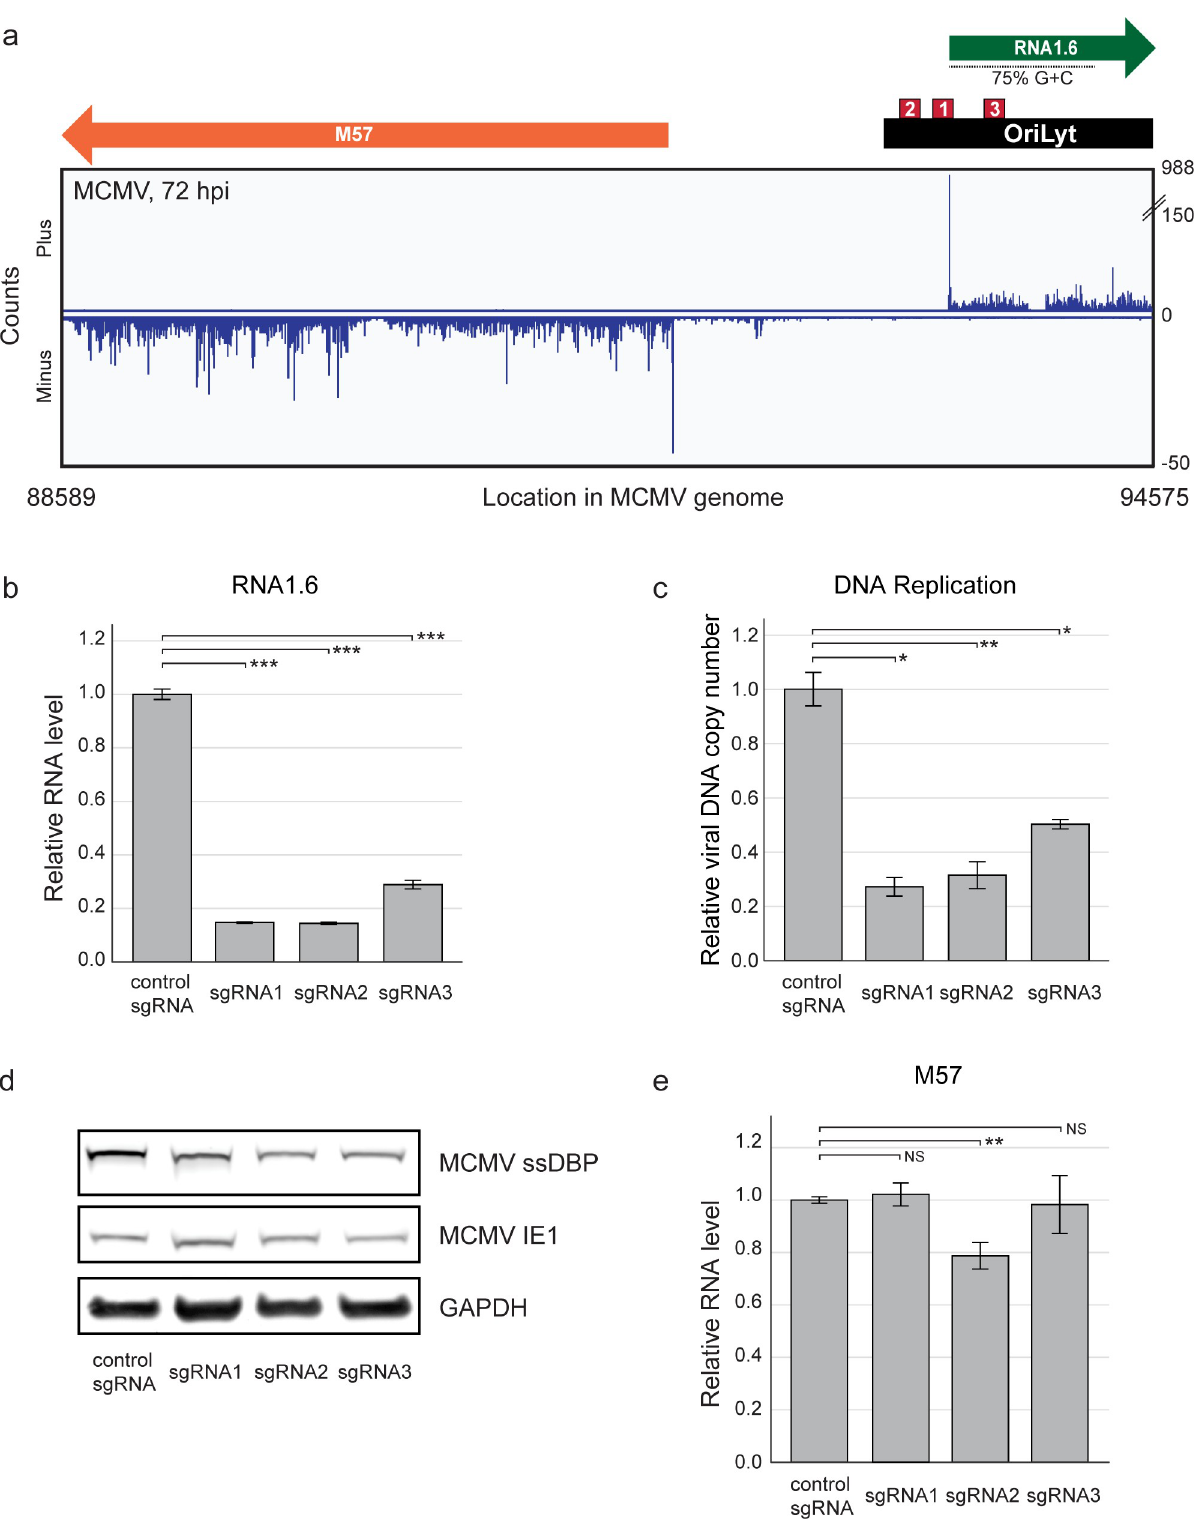
Fig 8. MCMV RNA1.6 KD is associated with reduced ssDBP levels and inhibition of viral DNA replication. a) Polyadenylated RNA profile of the MCMV Smith strain (NC_004065.1) genomic locus encompassing M57 (encoding ssDBP, orange), oriLyt (black) and RNA1.6 (green) with its G+C- rich region (dashed line), at 72 hpi (MOI = 1). sgRNA PAM sites (shown in red boxes; sgRNA1–93412, sgRNA2–93378, sgRNA3–93495) are displayed.